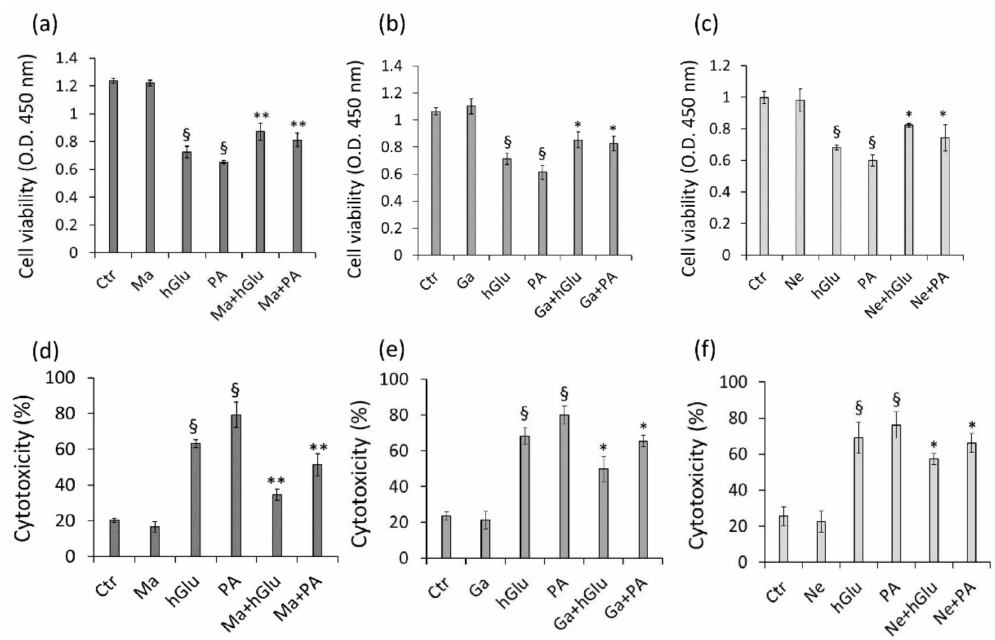
Figure 2. Endothelial protective effects of red wines during insulin resistance and hyperglycemia. ( a – c ) Cell viability and ( d – f ) cytotoxicity were evaluated by pretreating (12 h) EC with Ma, Ga, or Ne (6 µ g/mL) before exposure to hGlu (30 mM) or PA (0.5 mM) for 48 h. Control cells were treated with corresponding volumes of Hanks’ balanced salt solution (HBSS)–10 mM of Hepes. Cell viability was assessed by Cell Counting Kit-8 (Donjindo Molecular Technologies, Inc., Rockville, MD, USA). Cytotoxicity by LDH Assay Kit-WST (Donjindo Molecular Technologies, Inc., Rockville, MD, USA) and expressed as the mean ± SD of n = 5 replicates. § p < 0.01 vs. Ctr, * p < 0.05 vs. hGlu or PA, and ** p < 0.01 vs. hGlu or